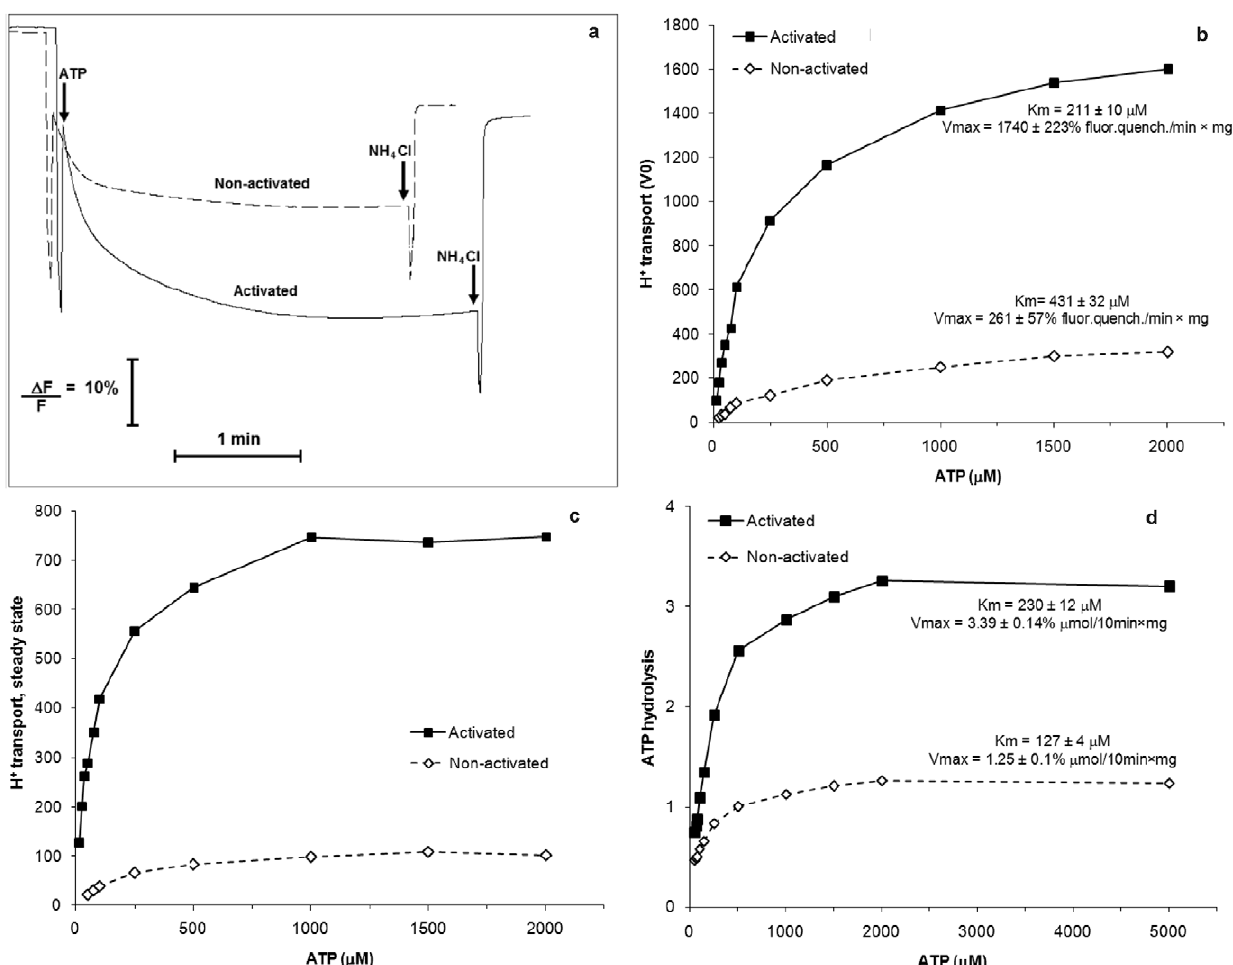
Figure 5. Activity of the V H + -ATPase in TM vesicles isolated from yeast spheroplasts pre-incubated in the absence or presence of 100 mM glucose. The H + transport into the TM vesicles was determined using fluorescence quenching of ACMA in the presence of 1.0 mM ATP (a) or in the presence of 0.015–2.0 mM ATP (activated enzyme) and 0.025–2.0 mM ATP (non-activated enzyme) (b and c, respectively). The V 0 of ATP hydrolysis (d) was determined by measuring the Pi release after 10 min of incubation. The V 0 (b) and steady state (c) of the H + transport are presented as a percentage of fluorescence quenching/min 6 mg of protein and as a percentage of fluorescence quenching 6 mg 2 1 of protein, respectively; the ATP hydrolysis is in m mol of Pi/mg protein 6 10 min (for other details see ‘‘Methods’’).